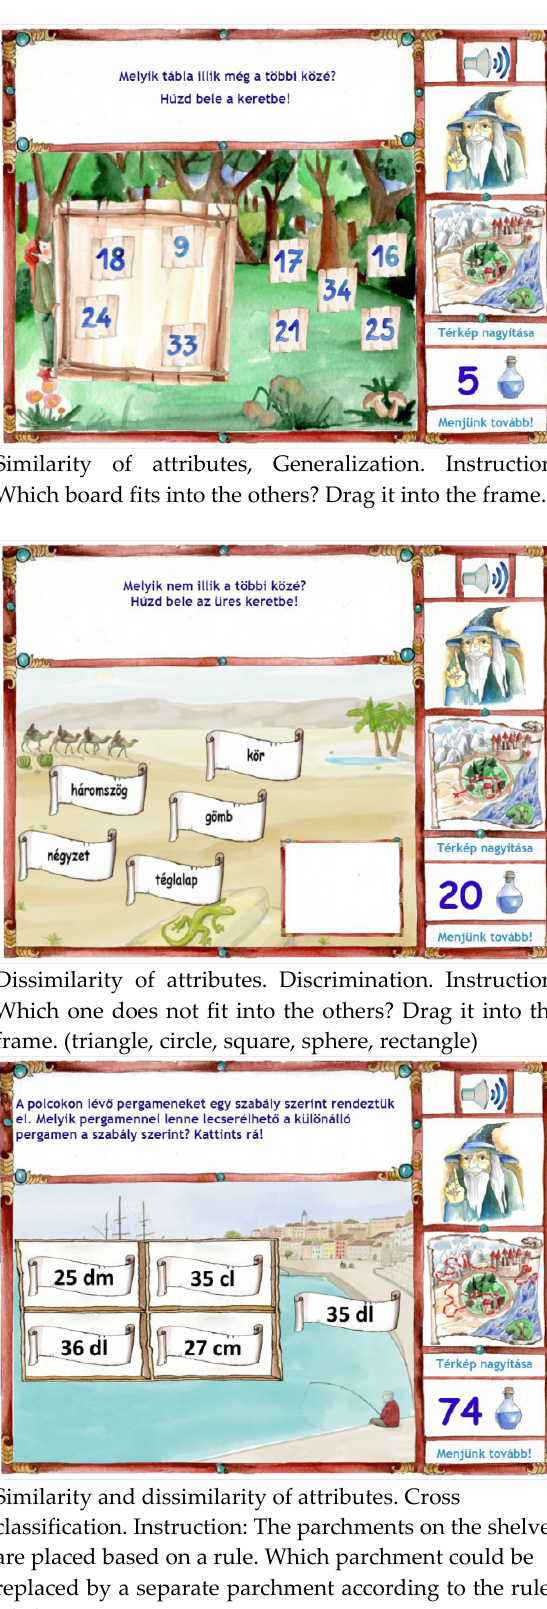
Figure 3. Sample learning tasks from the training program.